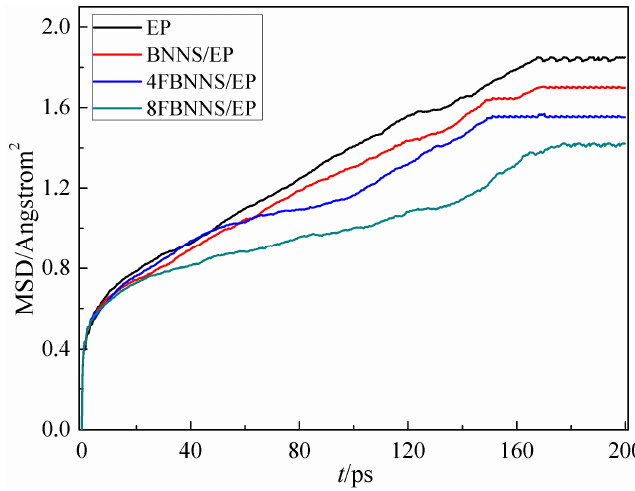
Figure 9. Mean square displacement (MSD) of BNNS/EP nanocomposites.